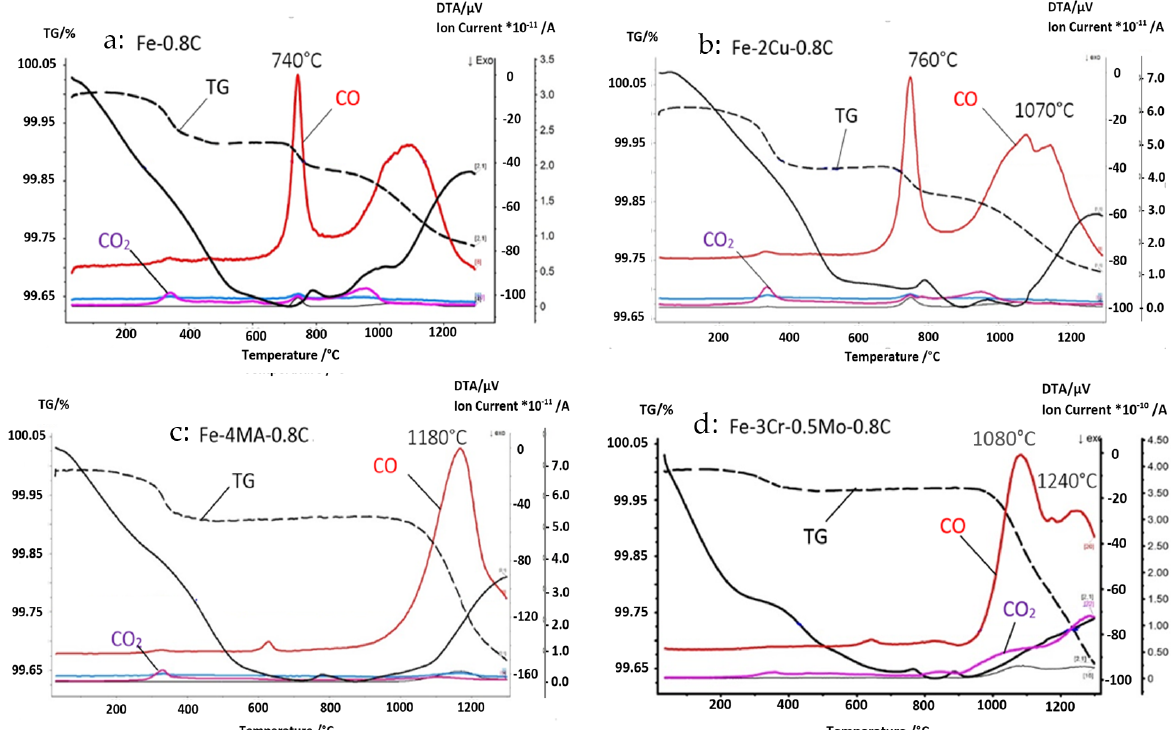
Figure 2. DTA/TG graphs with MS for different steels, heating rate 20 Kmin − 1 , T max = 1300 °C, argon. a) Fe-0.8%C; b) Fe-2%Cu-0.8%C; c) Fe-4%MA-0.8%C; d) Fe-3%Cr-0.5%Mo-0.8%C. a), b), c) mixed; d) prealloyed